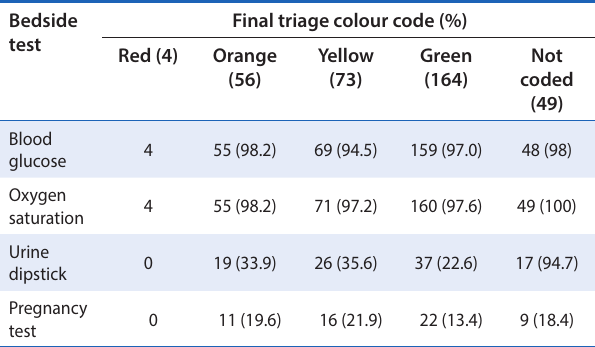
Note: Percentage is of the total number per colour